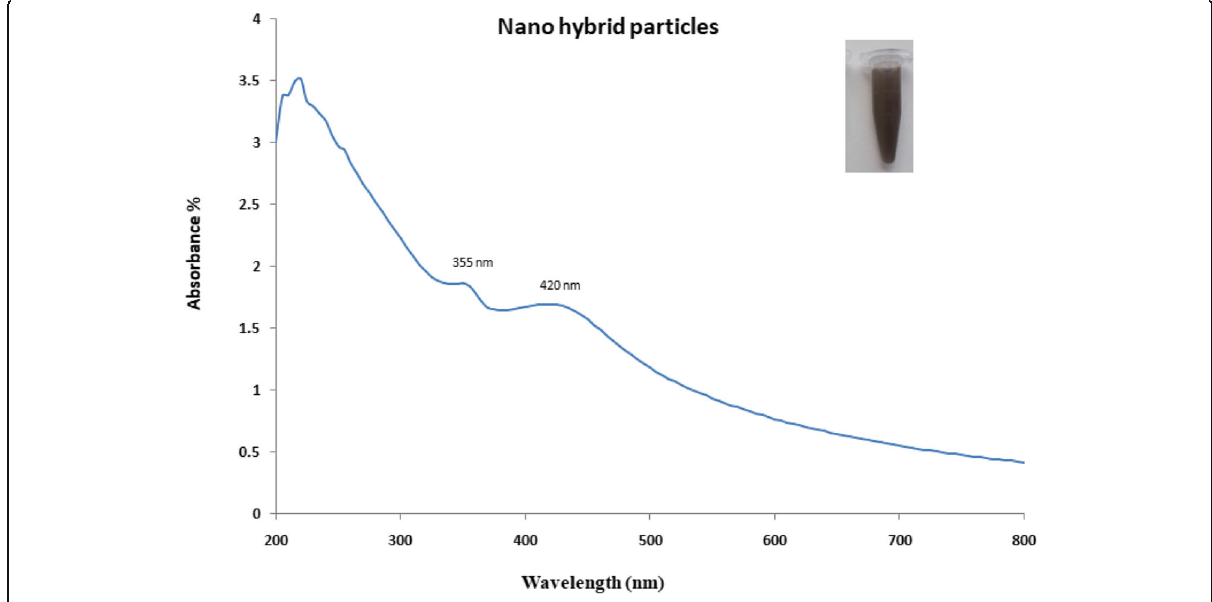
Fig. 1 UV spectrum of nano hybrid particles (Ag-CuO)